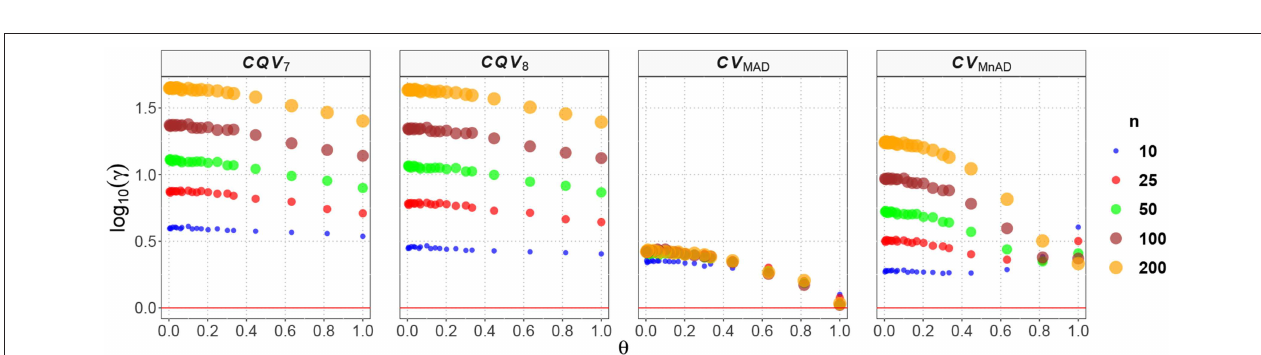
independently of θ and showed higher values than the CV MnAD . Figure 7 reveals our findings for the